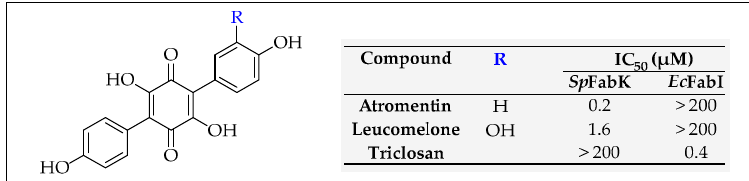
Figure 42. Structures and inhibitory activities of atromentin and leucomelone [171].